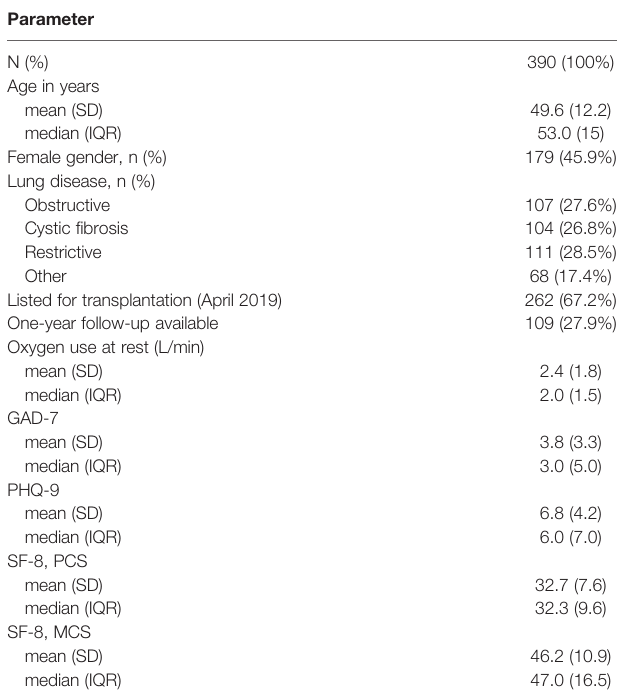
TABLE 1 | Characteristics of study